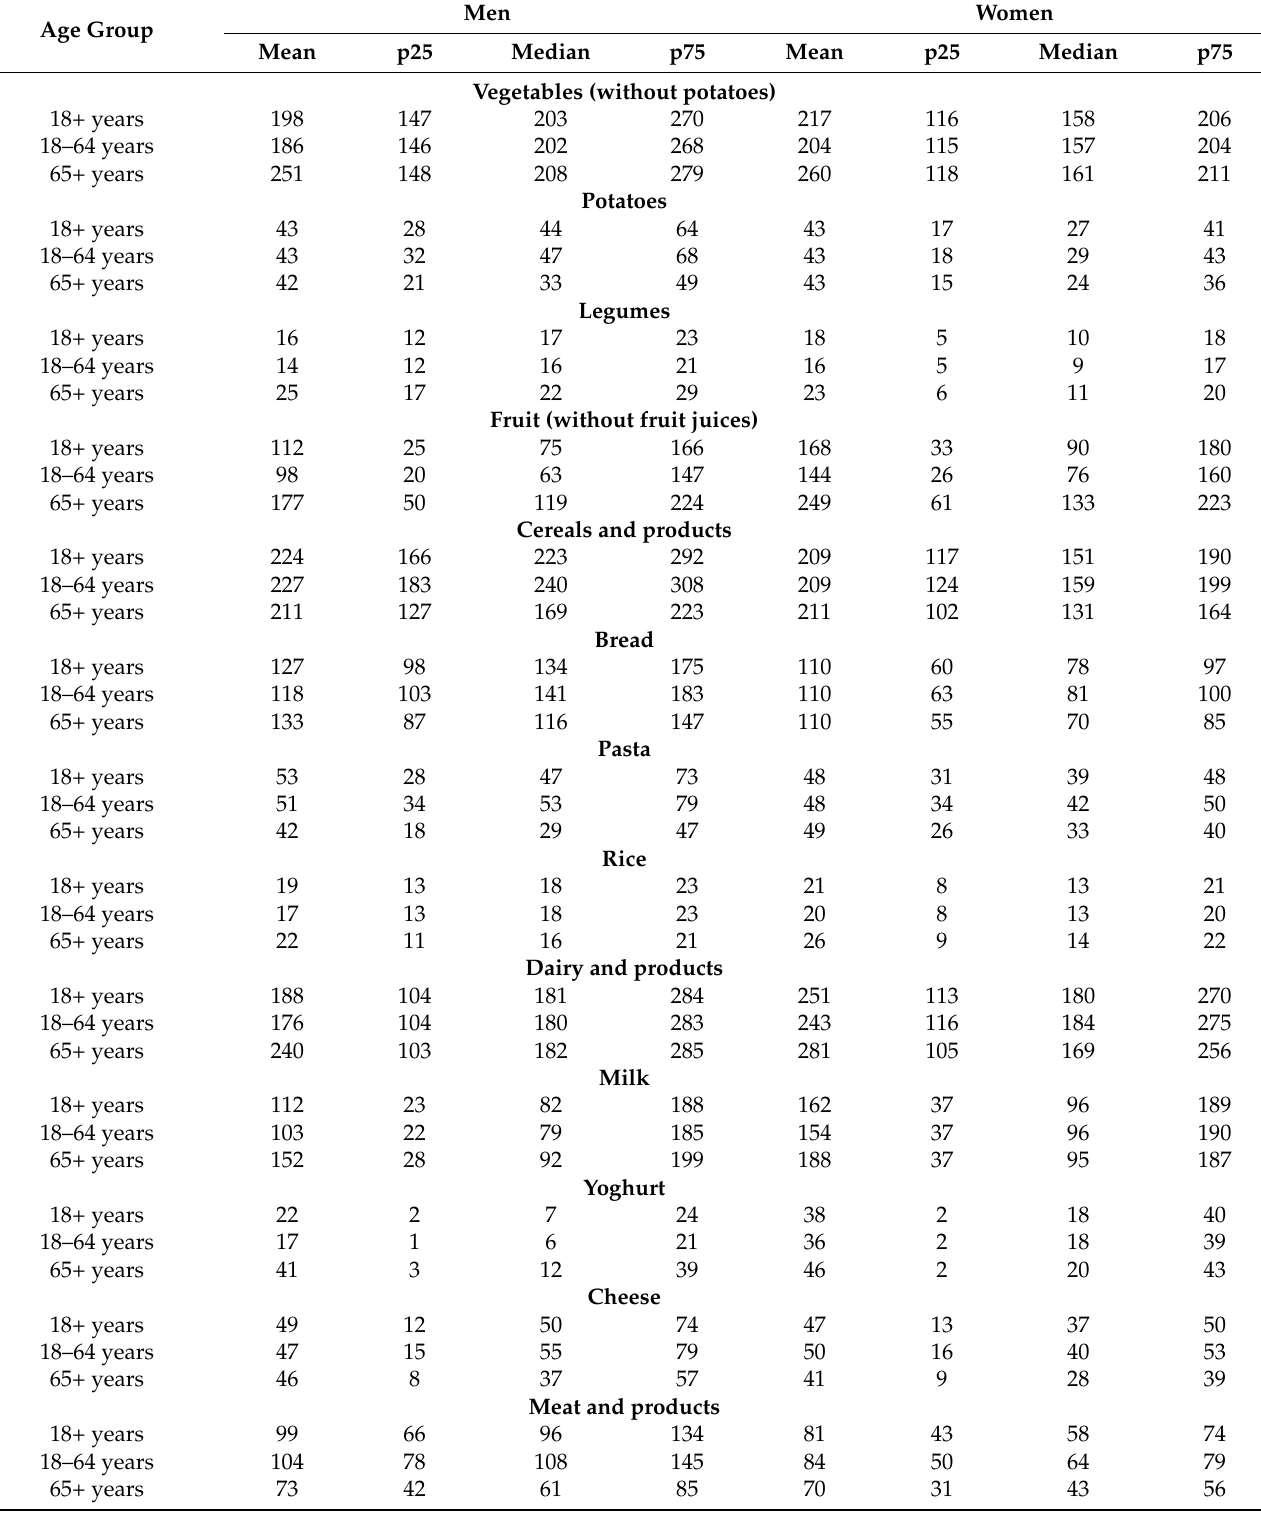
Table 4. Mean (energy-adjusted), median, and percentiles (25th and 75th) distribution of the usual daily intake (g) of food groups and subgroups † in the Greek National Health and Nutrition Survey— HYDRIA.